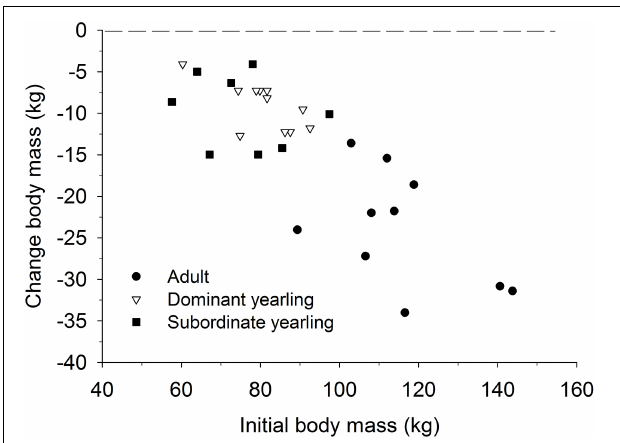
FIGURE 6 | Pair-wise comparisons of serum concentrations of testosterone (ng/ml) and cortisol ( µ g/dl) measured immediately before the rut in mid-Oct and after the rut in mid-Dec for adult ( ≥ 4.5-years old; n = 3), dominant yearling (1.5-years old and adult male absent; n = 5), and subordinate yearling (1.5-years old and adult male present; n = 4) white-tailed deer during 2010–2011, Brookings, SD, United States.